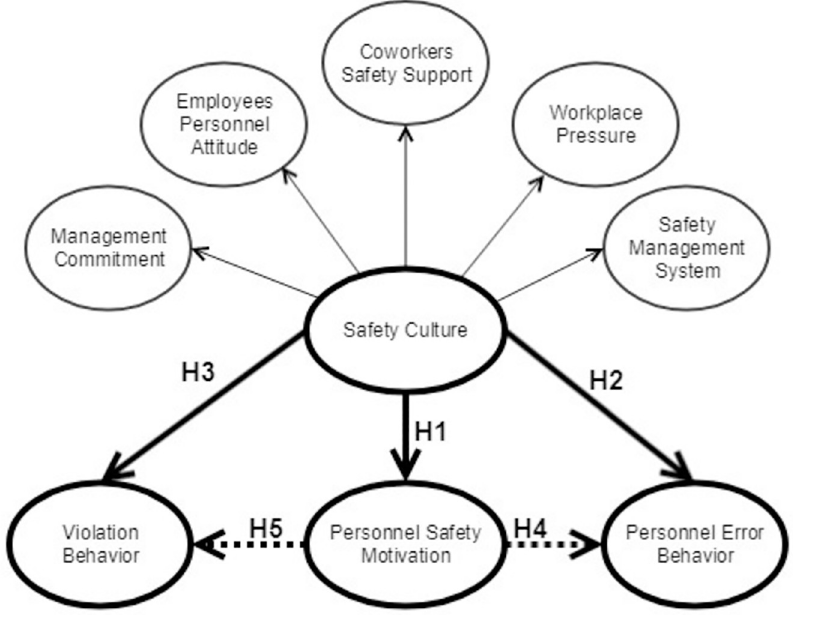
Fig 1. The hypothesized conceptual